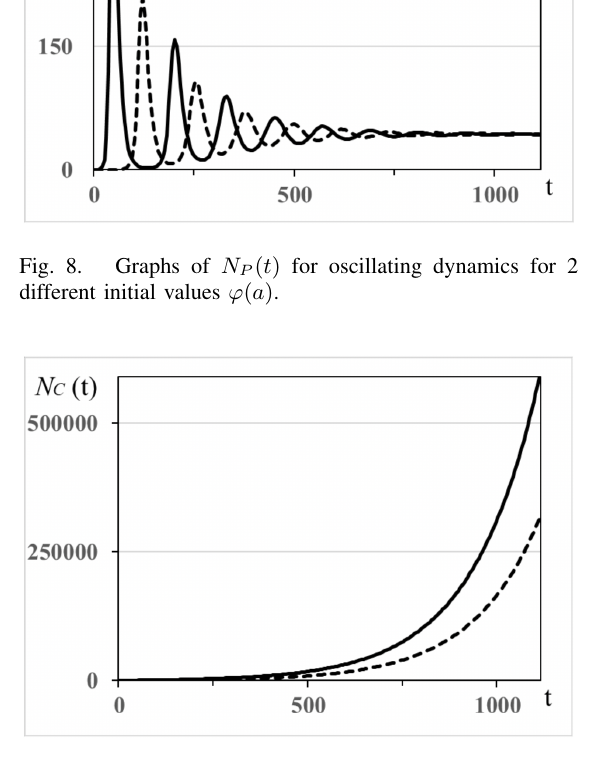
Fig. 9. Graphs of N C ( t ) for unstable dynamics for 2 different initial values ϕ ( a ) .